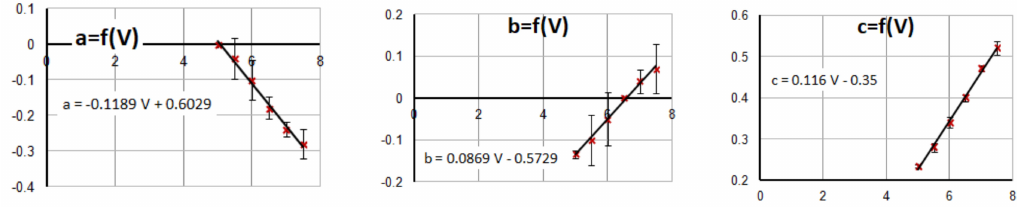
Figure 10. Dependence of coefficients a, b and c on wind velocity for single-segment